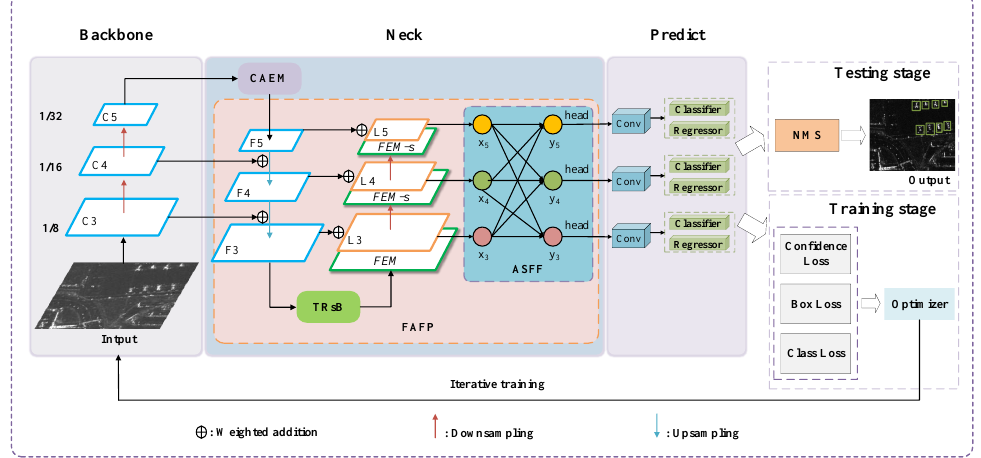
Figure 2. The architecture of the SFRE-Net, including backbone, neck, and prediction. SFRE-Net consists of input, backbone, neck, and prediction. The input part enriches the training dataset by mosaic [38], random horizontal flip, and random rotation data expansion methods. Inspired by YOLOV5 [39], SFRE-Net uses CSPDarknet53 [38] as the backbone, with lightweight parameters and a strong feature-extraction ability. The neck